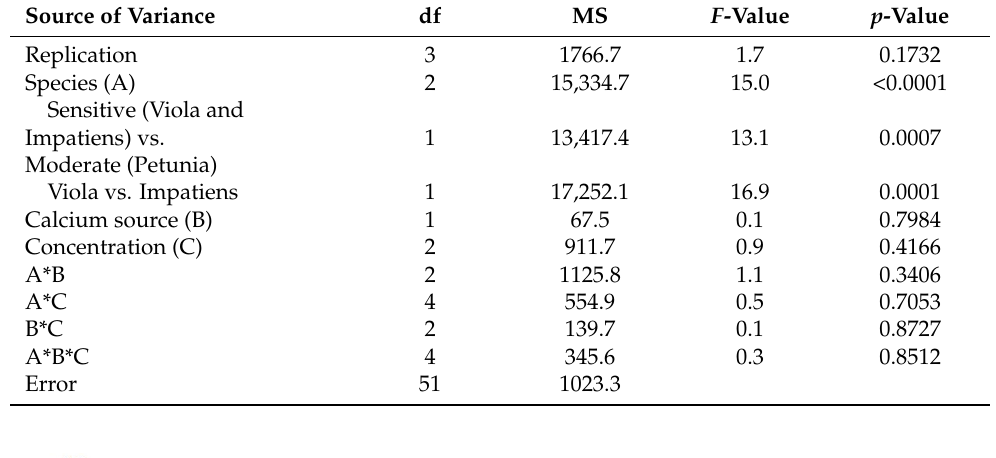
Table 1. Factorial ANOVA on shelf life extension in spray application.